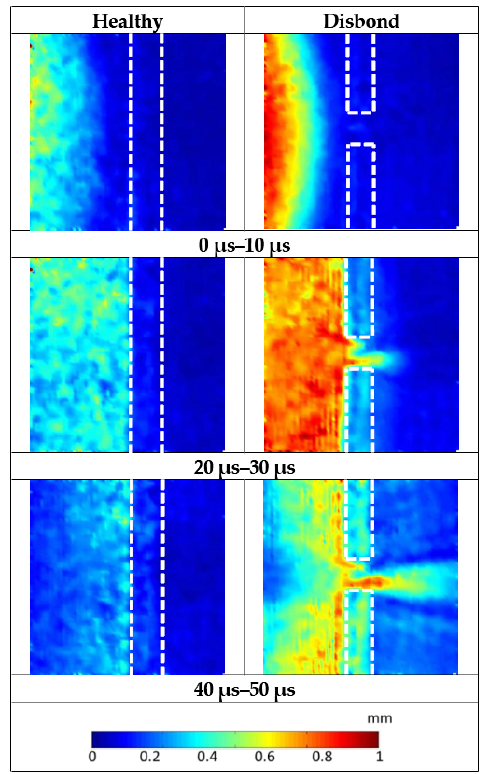
Figure 11 . Windowed RMS of the three-component displacement magnitude plots for 300 kHz excitation. Figure 11. Windowed RMS of the three-component displacement magnitude plots for 300 kHz